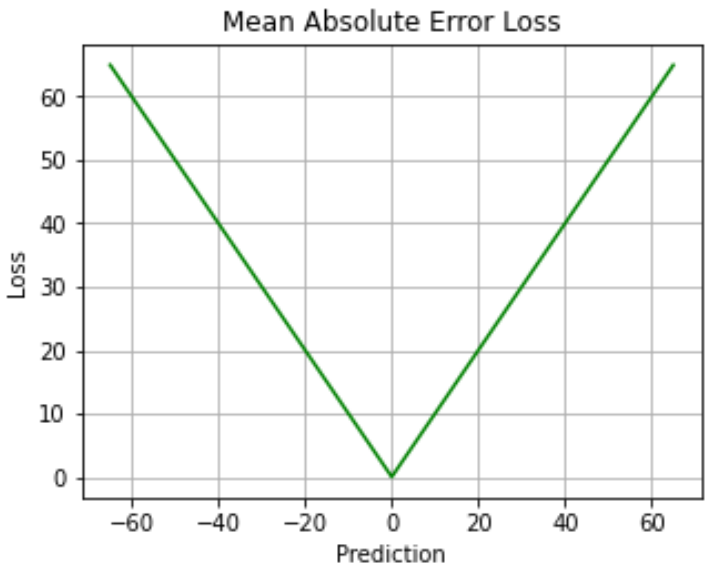
Figure 4. Mean Absolute Error (MAE).